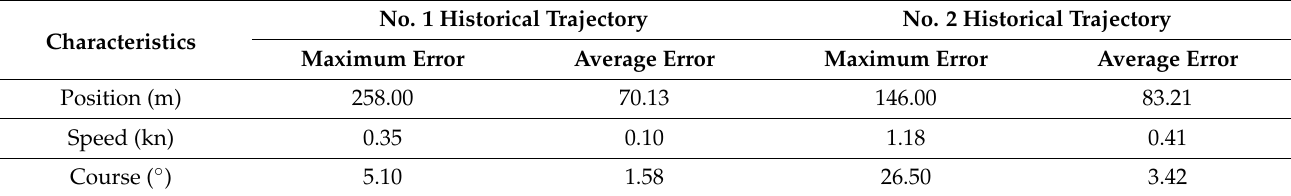
Table 9. The prediction results of test trajectories based on LSTM.